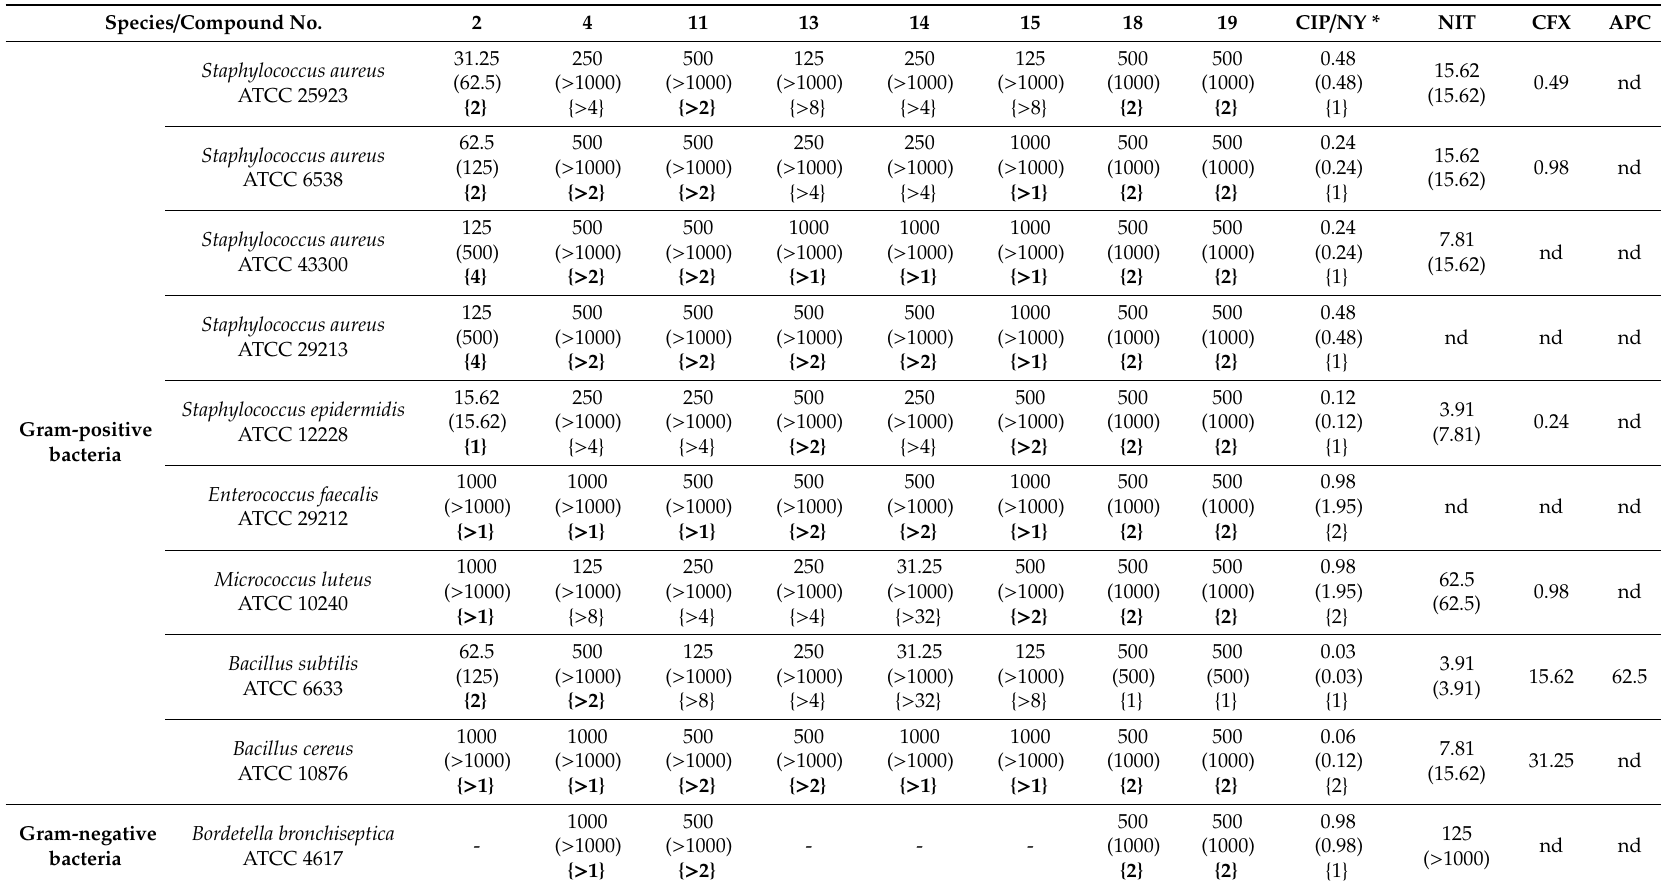
Table 1. The best active compounds expressed as minimal inhibitory concentration (MIC) (minimal bactericidal concentration (MBC) or (MFC) (minimum fungicidal concentration) ( µ g / mL) and (MBC / MIC or MFC / MIC) values against the reference strains of microorganisms. Species / Compound